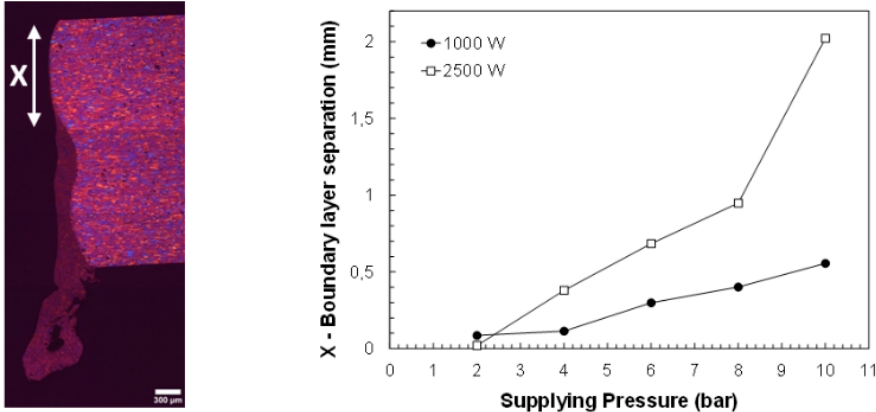
Figure 16. Detachment of the boundary layer as a function of the assist gas pressure during laser cutting of aluminum-copper alloys. Reprinted with permission from [30]; Copyright 2010 Elsevier .